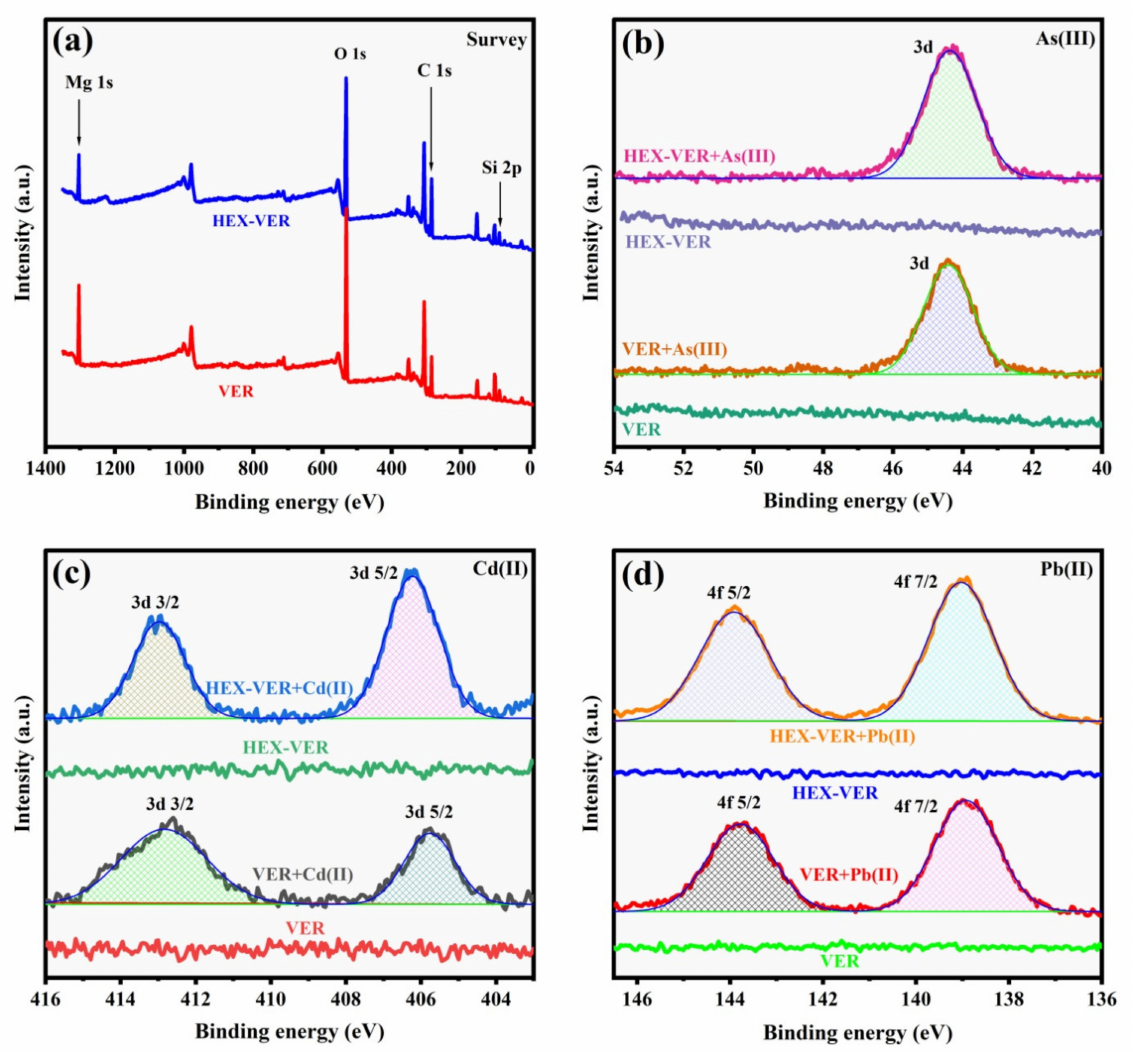
Figure 5. The XPS survey of VER and HEX–VER ( a ), high-resolution core-level spectra of before and after adsorption of As 3d ( b ), Cd 3d ( c ) and Pb 4f ( d